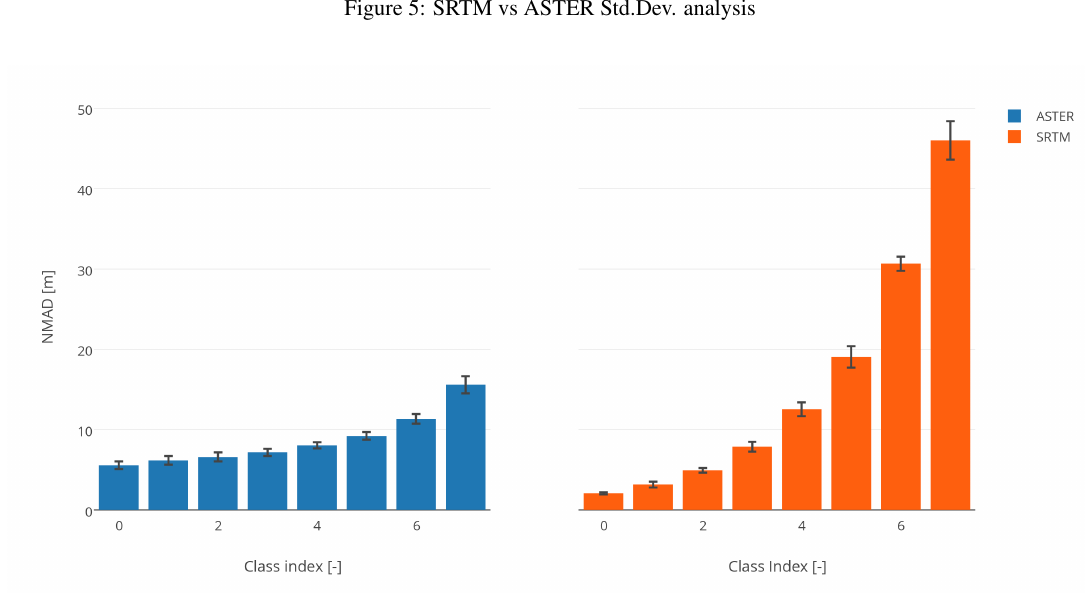
Figure 6: SRTM vs ASTER NMAD